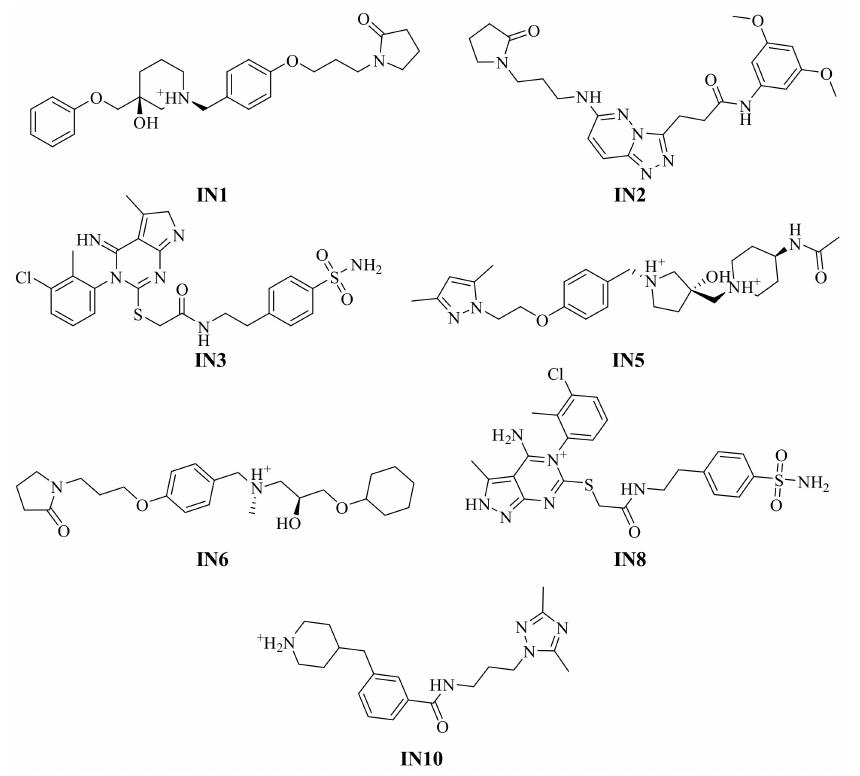
Figure 6. Selected potential inhibitors PLC γ 1 after the three replicate MD